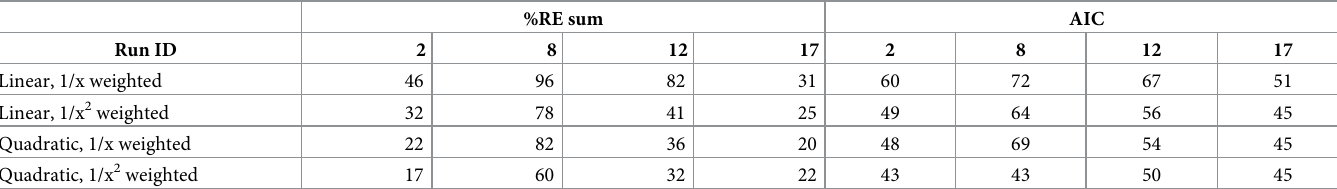
Table 3. Comparison of regression